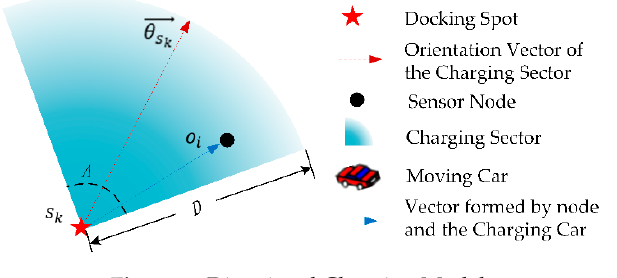
Figure 2. Directional Charging Model.